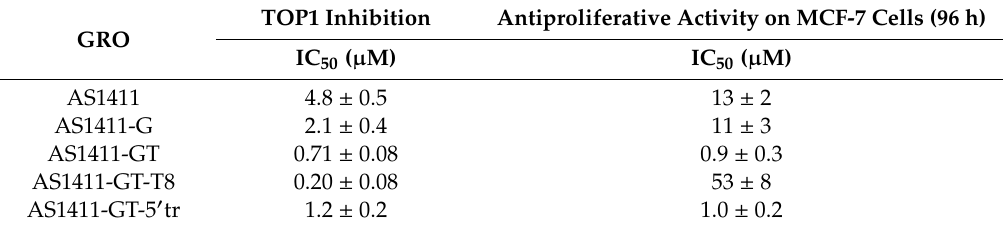
Figure 3. Inhibition of TOP1-catalyzed relaxation of supercoiled pUC19 plasmid in the presence of GROs. Dependence of enzyme inhibition percentage on the logarithm of GRO concentration was built according to the gel electrophoresis data quantified by ImageJ software. Table 4. Biological activity of GROs.